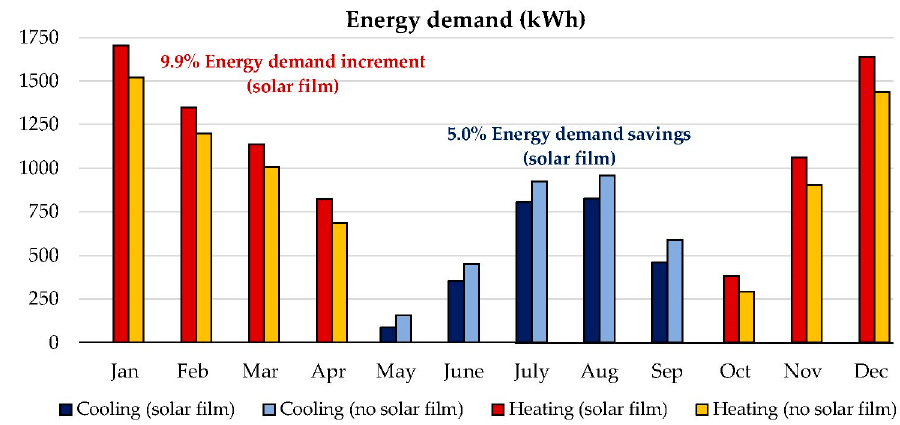
Figure 11. Monthly energy demand (kWh) of the cooling and heating systems in the room with and without solar protection film: with no cantilever. Source: Authors.